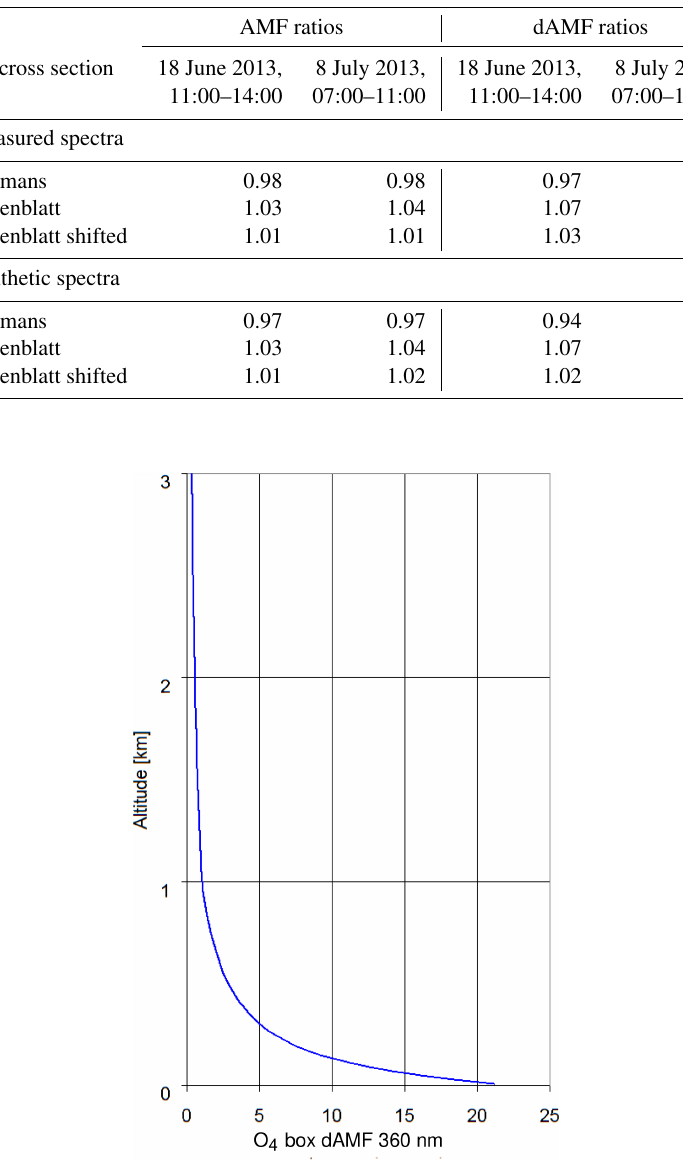
Table A23. Average ratios of O 4 (d)AMFs derived for the analyses using different O 4 cross section vs. those for the standard analysis (using the Thalman and Volkamer cross section) for the standard analysis (only one O 4 cross section) for the middle period on each selected day (top: results for spectra measured by the MPIC instrument; bottom: results for synthetic spectra when taking into account the temperature dependence of the O 4 cross section).